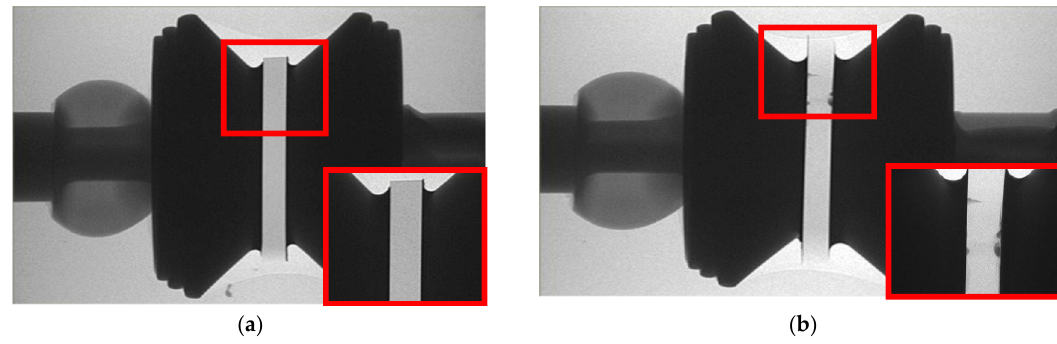
Figure 7. X-ray analysis images ( a ) normal bypass diode, ( b ) failed bypass diode.